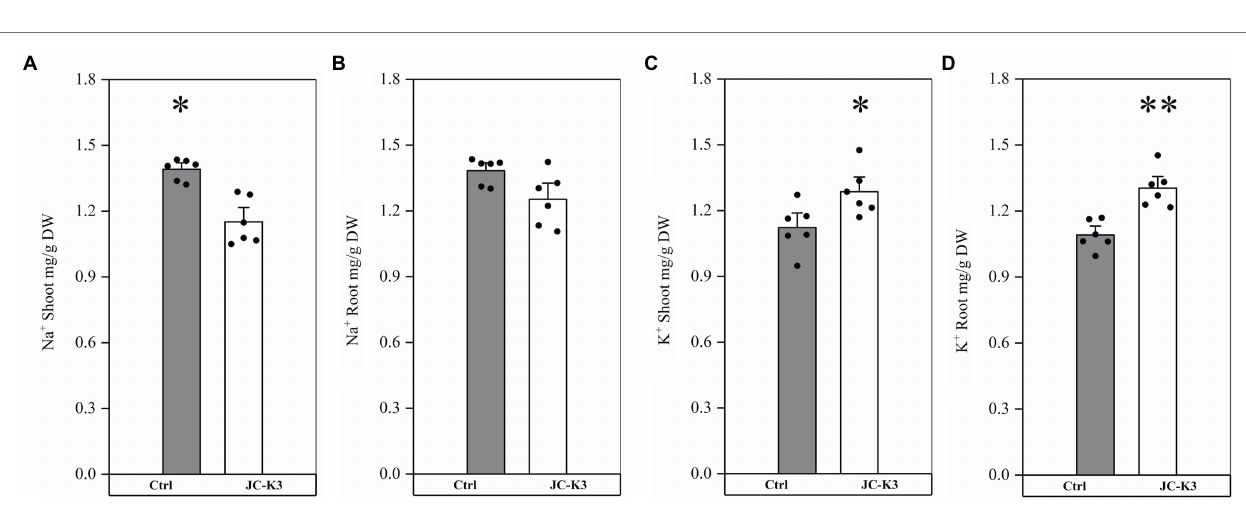
FIGURE 3 | Effect of inoculation of isolate JC-K3 on ionic uptake by plants. (A) Shoot Na + , (B) Root Na + , (C) Shoot K + , and (D) Root K + . Each value is the average of six replicates. The error bar represents the SE the average of six replicates. * on the bar chart of each treatment indicates the significant difference between the control group and the treatment group, * p < 0.05; ** p < 0.01 (Student’s t -test). The black and white columns represent the control (Ctrl) and JC-K3 inoculated plants,